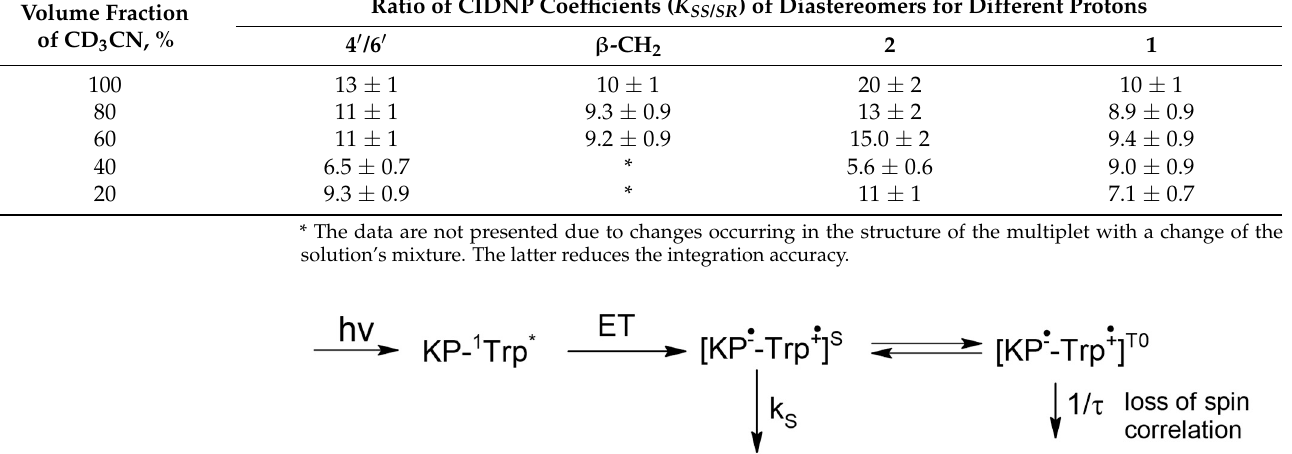
Table 5. Spin selectivity of protons in diastereomers of dyad IV detected in solvent with different dielectric constants (CD 3 CN/C 6 D 6 mixtures).